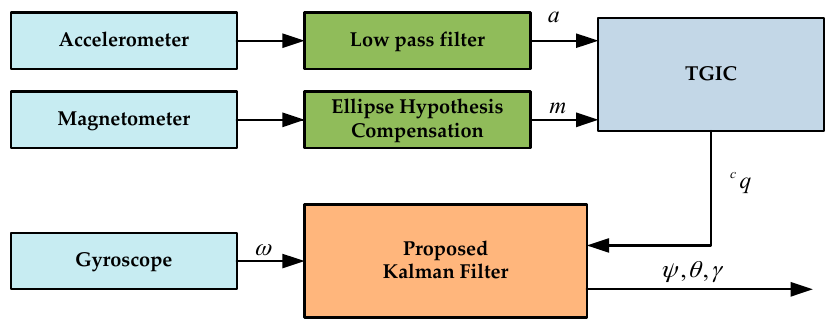
Figure 1. Block diagram of the proposed KF design.